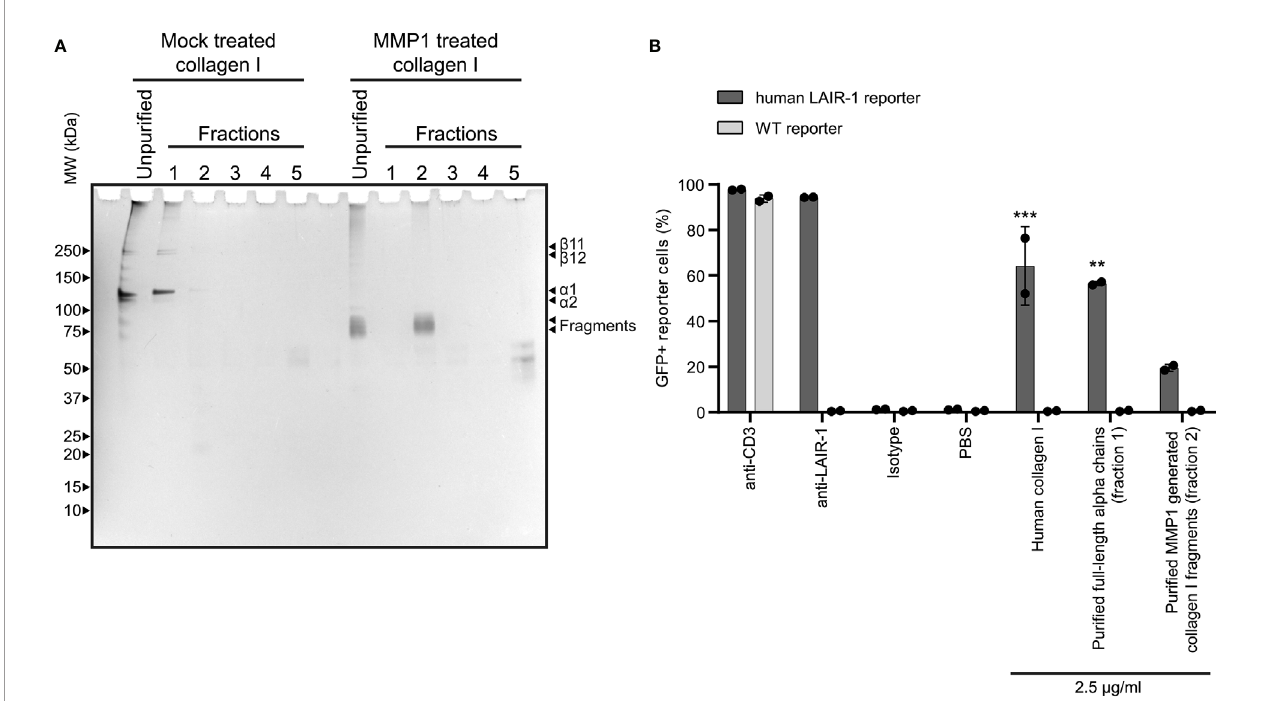
FIGURE 3 | Puri fi ed collagen I fragments are functional LAIR-1 ligands. (A) Analysis of puri fi ed full-length alpha chains and puri fi ed MMP1 generated collagen I fragments by SDS-PAGE and silver staining. (B) Flow cytometry analysis of NFAT-GFP reporter cells, representing LAIR-1 ligation (n = 2). Anti-human-LAIR-1, anti- mouse-CD3 and 2.5 m g/ml human collagen I are positive controls for reporter cell activation. The isotype antibody and PBS are negative controls. Statistically signi fi cant differences compared to WT reporter cells are indicated with * (tested using two-way ANOVA with Tukey ’ s multiple comparison